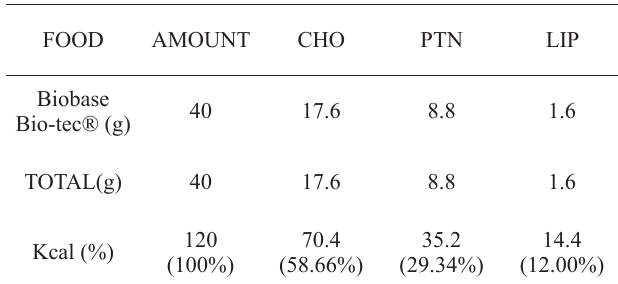
TABLE 1 - Composition of standard diet (STD): normoglycidic, hyperproteic,